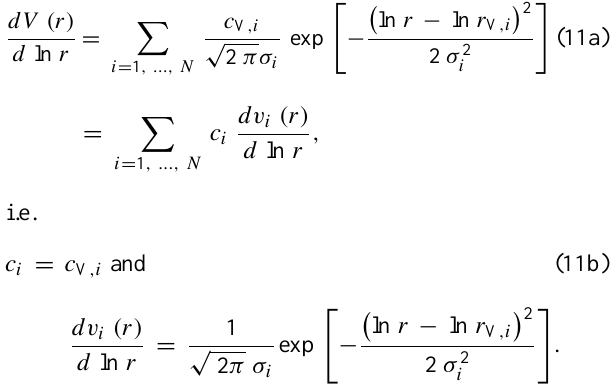
used for making accurate calculations of atmospheric